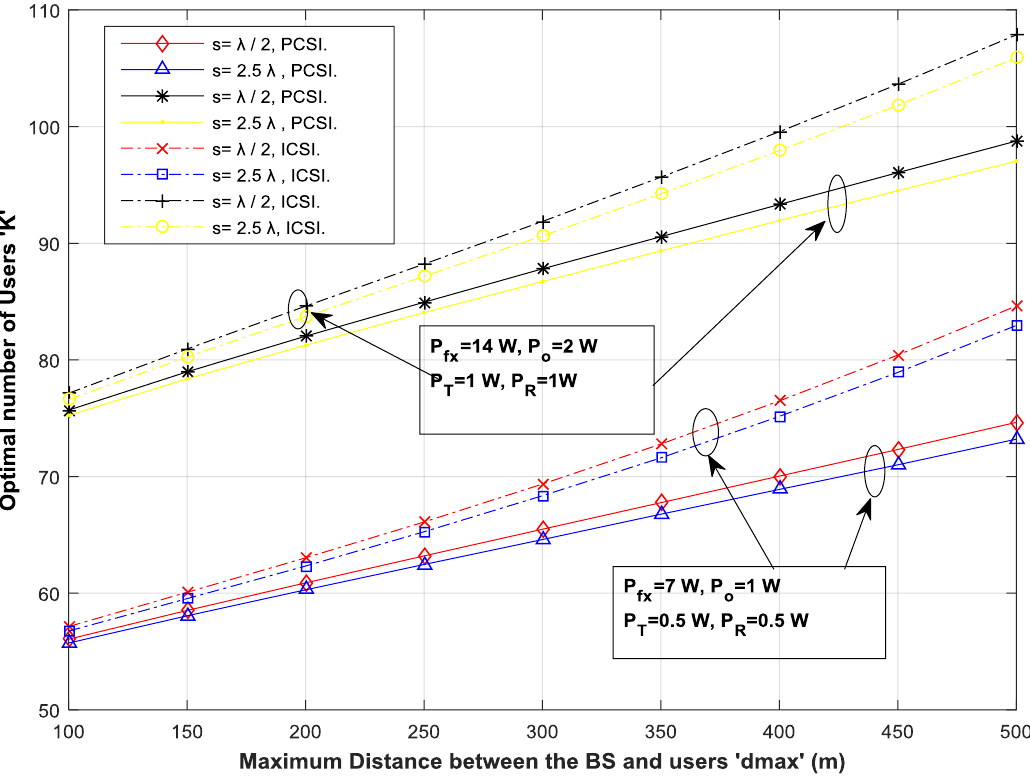
Figure 7. Number of optimal Users.